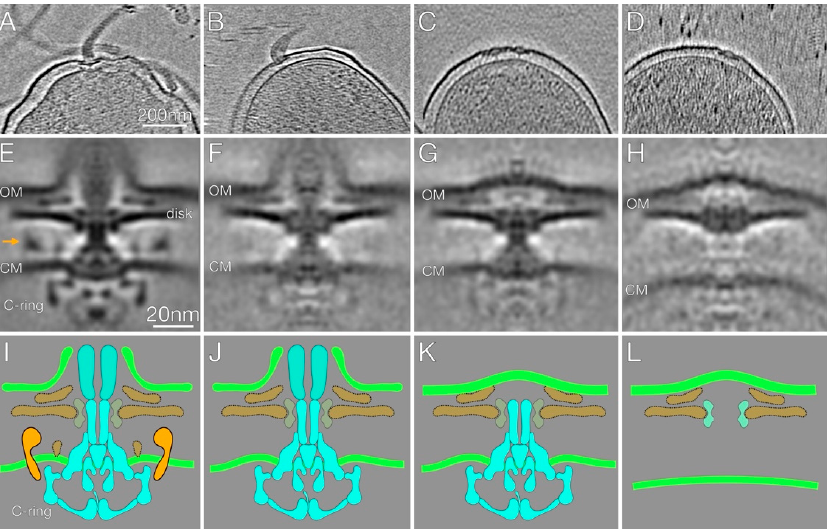
Figure 4. Visualization of flagellar motors of the H. pylori B128 ∆ hp1489 and ∆ hp1487 / hp1486 mutants by cryo-ET. ( A – D ) Representative slices of cryo-ET reconstructions show various aberrant forms of flagellar motor from the mutants. ( E – H ) Central slices of the averaged structures of the specific classes of flagellar motors. Each averaged structure is below the representative slice for the specific class of motor. ( I – L ) The corresponding cartoon illustrations for the various classes of motor structures. The color scheme is: orange, cage; brown, PflA/PflB, P-disk and basal disk; gray, L ring and P ring; cyan, C ring, MS ring, export apparatus, rod, and hook; green, outer membrane/flagellar sheath; light green, inner